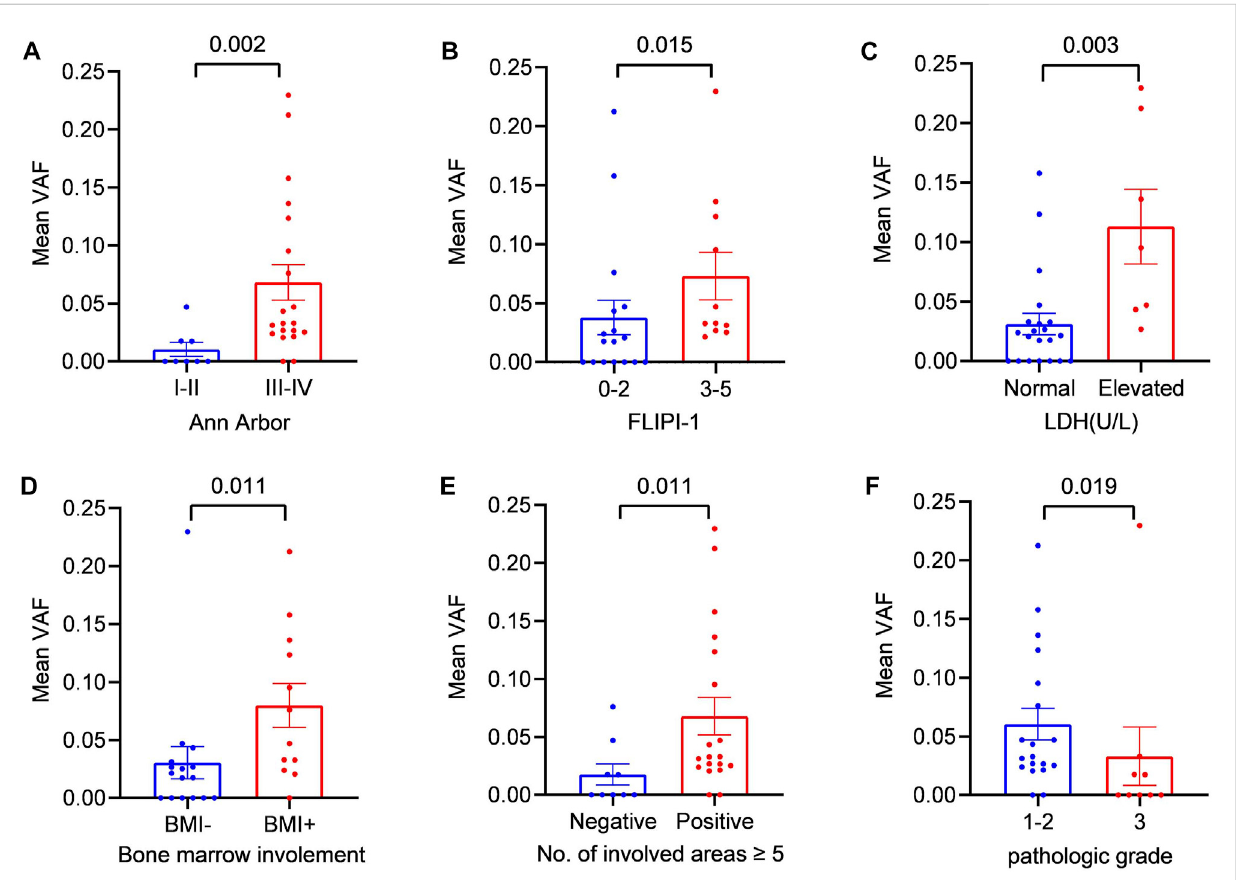
FIGURE 2 Relationship between the mean VAF and the clinical features of patients with newly diagnosed FL (A) Patients were divided into two groups according to Ann Arbor staging: the early-stage (I + II) group and the late-stage (III + IV) group (B) Statistical comparison between the low-FLIPI (0 – 2) group and the high-FLIPI (3 – 5) group was performed (C) Patients were divided into two groups according to LDH level: the elevated LDH group and the normal LDH group (ULN) (D) Patients were divided into two groups according to whether bone marrow was involved: BMI (+) and BMI ( − ) (E) Statistical comparison between the group with ≥ 5 lymph node-involved areas and the group with < 5 lymph node-involved areas was performed. (F) Statistical comparison between the grade 1 – 2 cases and grade 3 cases was